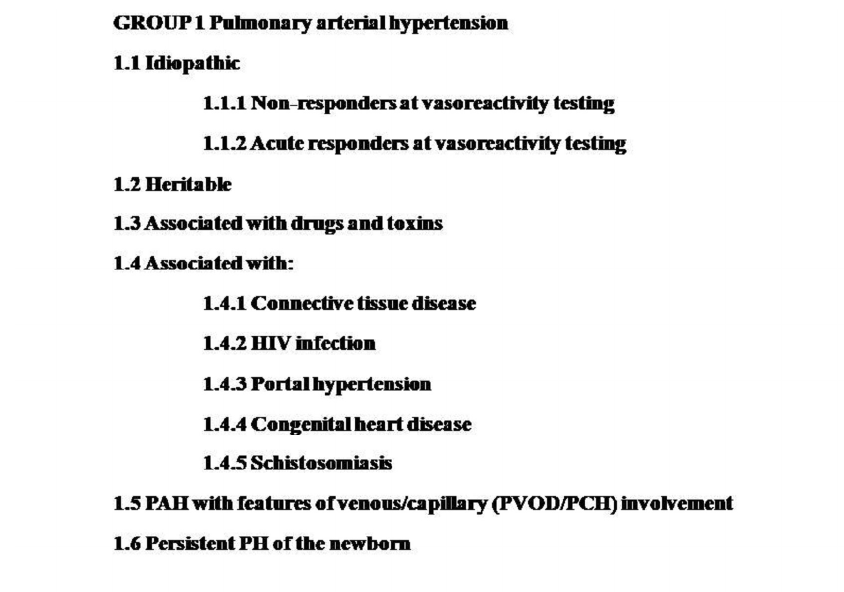
Figure 1. Clinical classification of pulmonary hypertension.